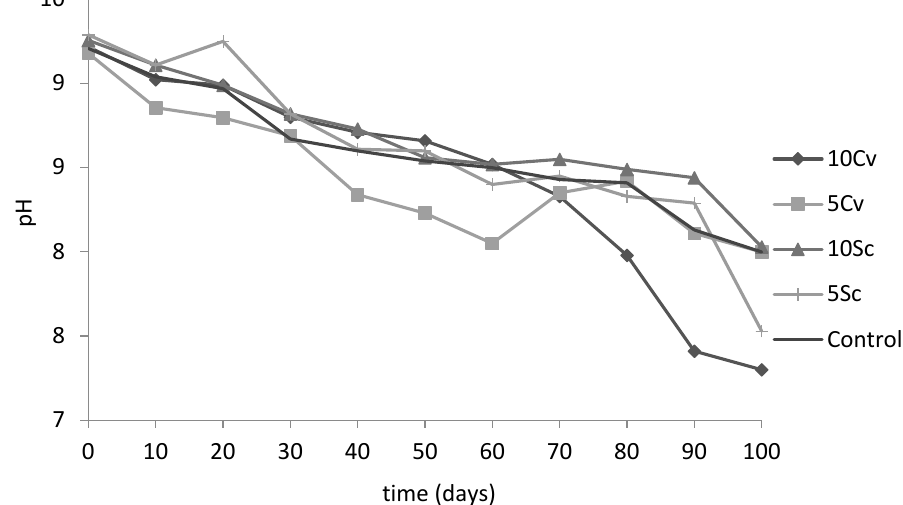
time (days) Figure 2. Chlorophyll-a concentration observed during the batch culture cultivation of microalgae. The contaminants contained in the wastewater affected the duration of individual growth phases of the microalgae population. The analysis of the individual growth phases of microalgae (based on changes in chlorophyll-a) revealed that for the concentration of microalgae of 100 g/L, the logarithmic growth phase began after ten days and lasted for the next thirty days. The following phases of microalgae population growth were ob- served: lag, exponential (logarithmic) growth, stationary and death phase. However, in the samples containing S. armatus microalgae, the death phase began by the fiftieth day, which can be explained by the lower resistance of this species of algae, compared to C. vulgaris , and to the contaminants contained in the wastewater. Furthermore, in the case of microalgae C. vulgaris , after completion of the stationary phase (from 40 to 50 days) the phase of a very slow logarithmic growth started and lasted until the end of the research. It can be concluded that industrial wastewater with high ammonium concentrations can be used to cultivate microalgal biomass of C. vulgaris and S. armatus species. Figure 3 presents changes in pH values with time during cultivation of C. vulgaris. and S. armatus in wastewater.